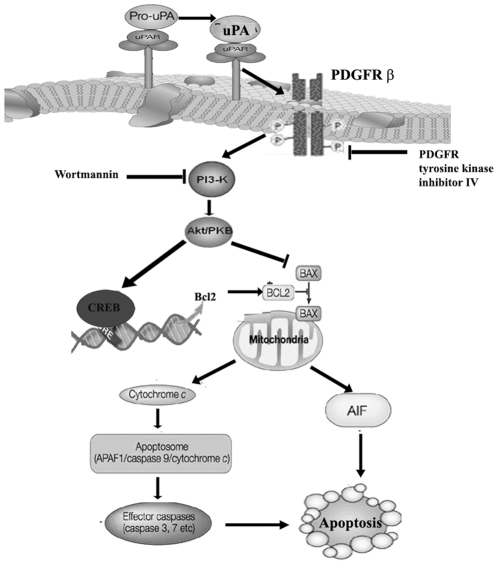
Schematic representation of proposed molecular mechanisms involved in the regulation of mitochondrial-mediated apoptosis via PDGFR β and the PI3K/Akt pathway in uPAR and cathepsin B-depleted glioma cells.